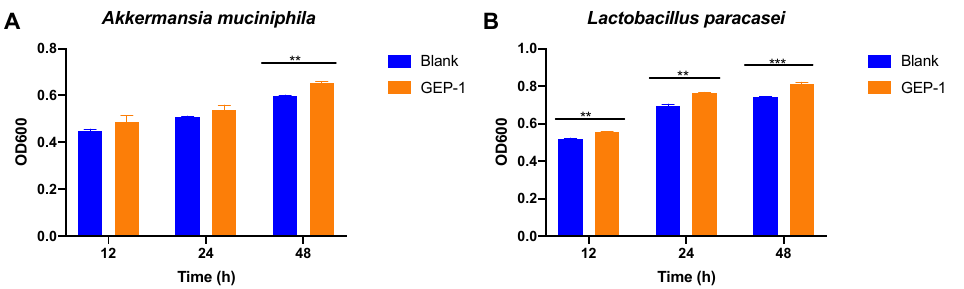
Figure 5. ( A ): The growth of A. muciniphila in the medium containing 1 mg/mL GEP-1 for 12, 24 and 48 h; ( B ): The growth of L. paracasei in the medium containing 1 mg/mL GEP-1 for 12, 24h and 48 h. ( n = 3, by student t test, ** p < 0.01, *** p < 0.001.).